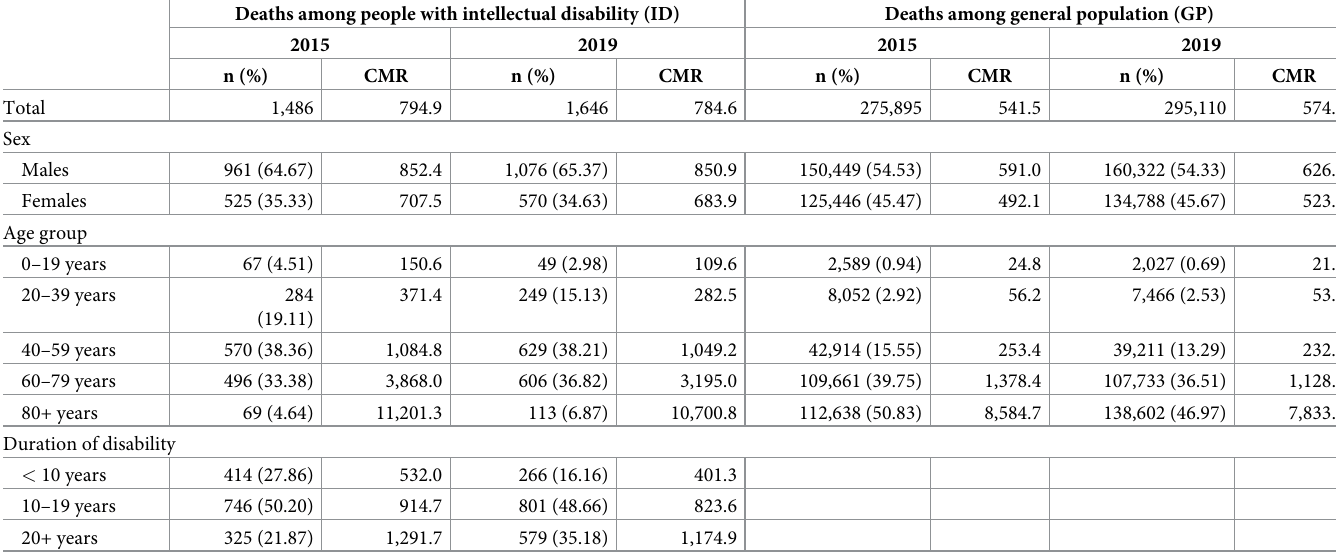
Table 1. Demographic characteristics of deaths among people with intellectual disabilities and the general population in 2015 and 2019. Deaths among people with intellectual disability (ID)